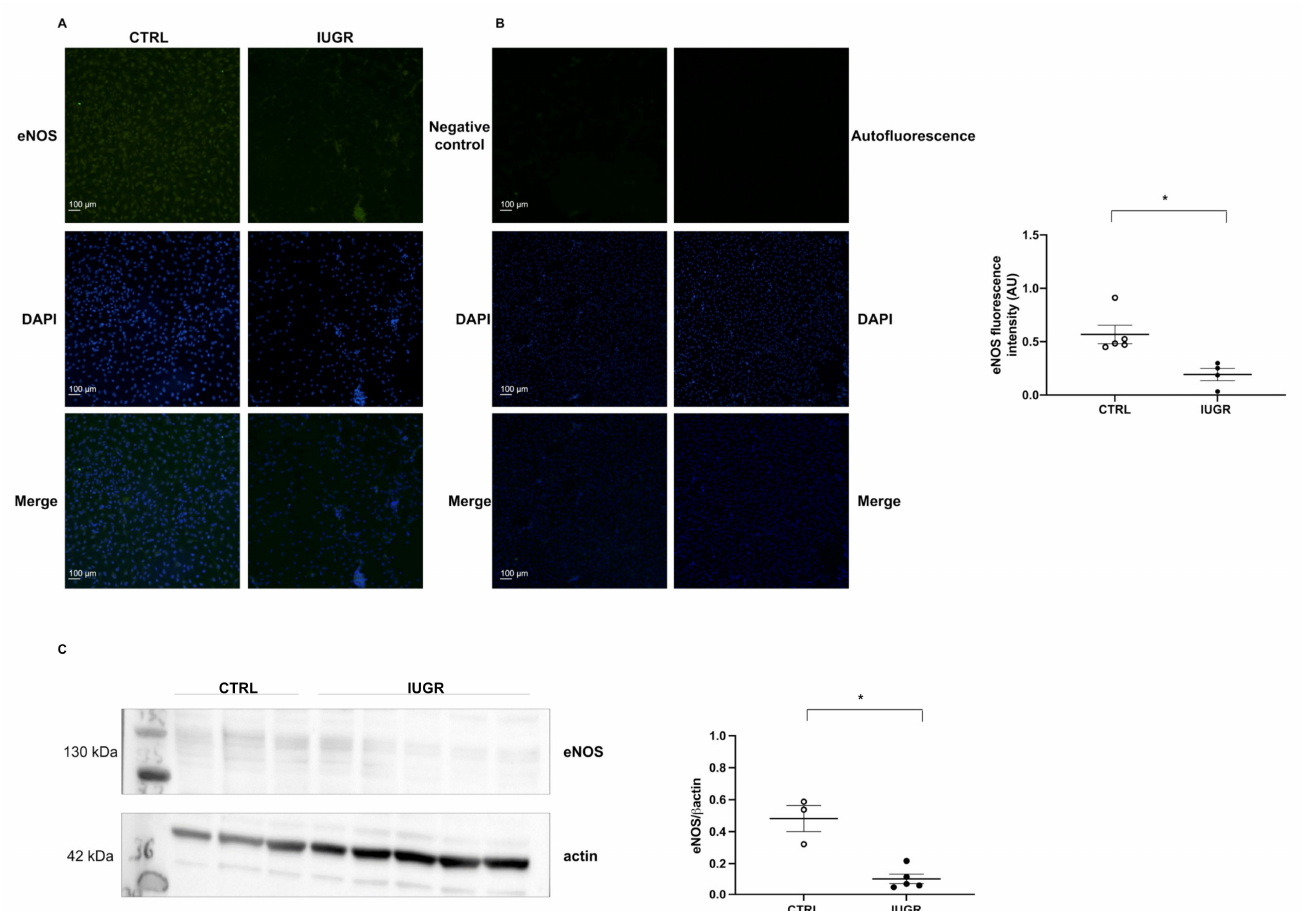
Figure 6. eNOS protein expression in ECFCs. eNOS protein expression was measured by immunofluorescence in CTRL- ECFCs and IUGR-ECFCs isolated from six-month-old male rats ( A ). Magnification (20 × ). Nuclei were counterstained with DAPI, and a negative control (with no primary antibody) and test for autofluorescence were performed ( B ). These pictures are representative images from n = 4–5 animals/group; * p < 0.05. Scale bar = 100 µ m. eNOS expression was also measured in CTRL-ECFCs and IUGR-ECFCs by western blot ( C